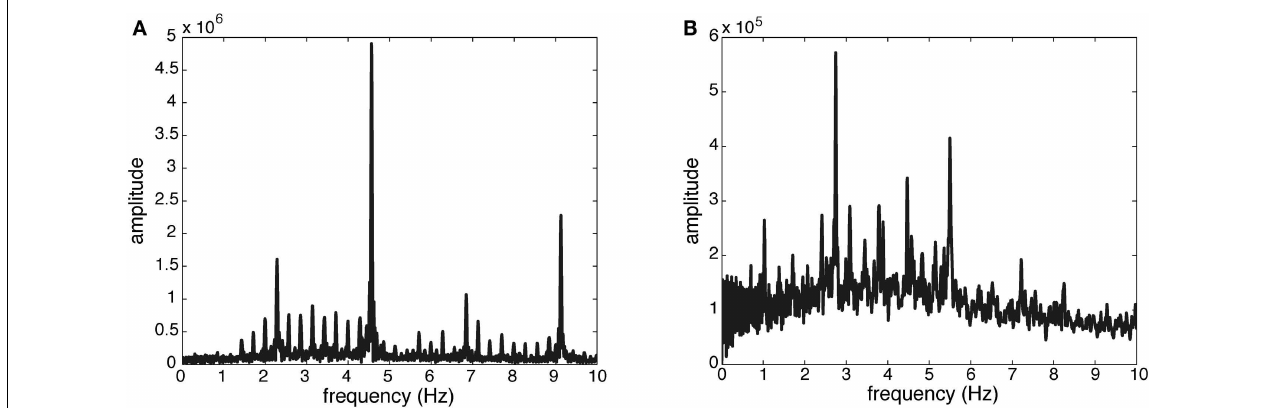
(stimulus 1, see Appendix). (B) Markedly lower magnitude values, a less periodic pattern of peaks, and more noise, suggesting low pulse clarity (stimulus 21, see